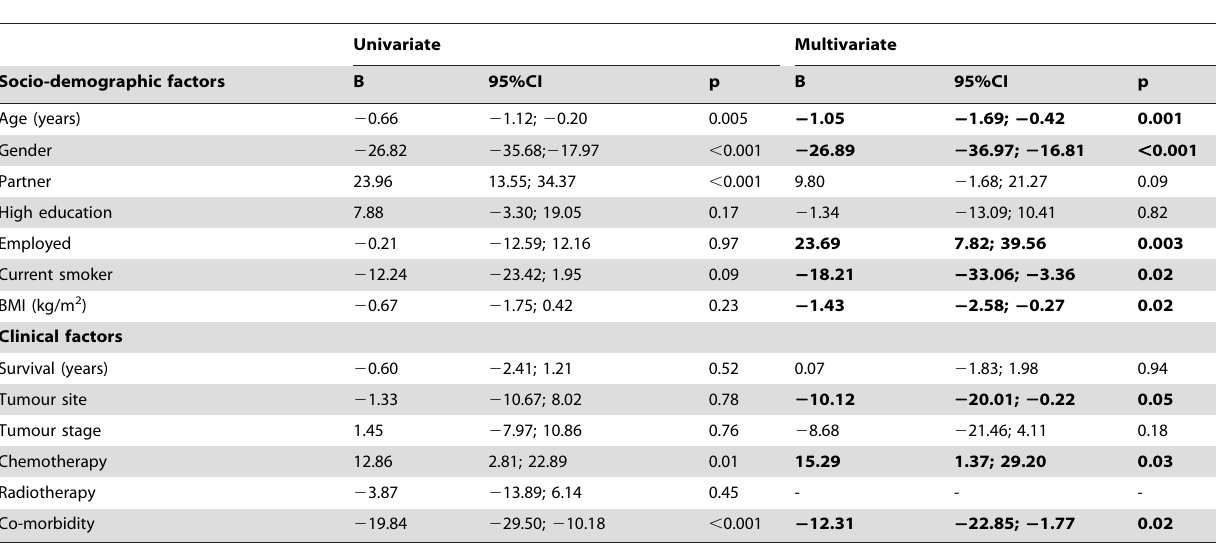
Table 2. Socio-demographic and clinical correlates of moderate-vigorous physical activity (min/day).